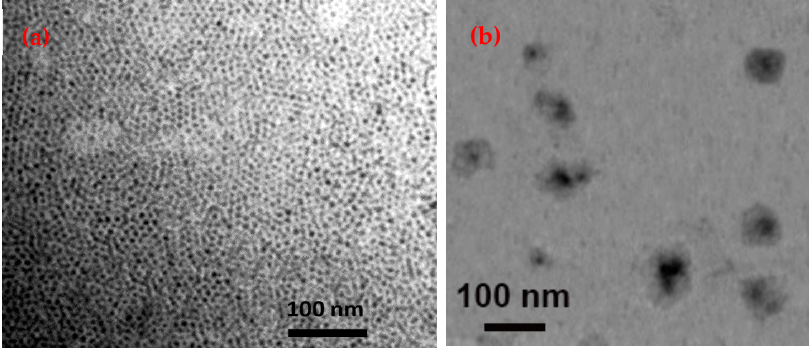
Figure 2. TEM micrographs of ( a ) Fe 3 O 4 , ( b ) Fe 3 O 4 nanoparticles and core-shell nanoparticles (FMNPs).